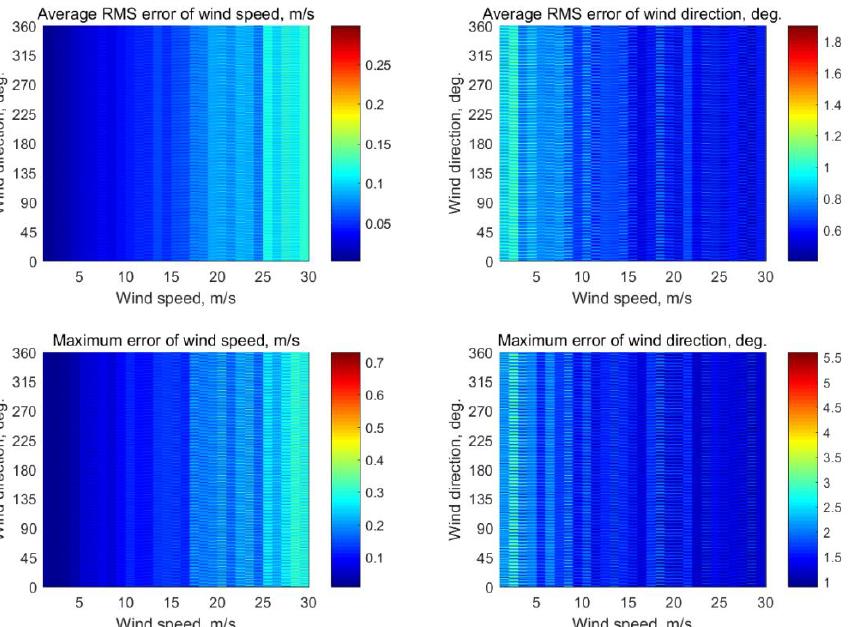
Figure A13. Simulation results of the use of two incidence angles of 55° and 60° for wind retrieval.